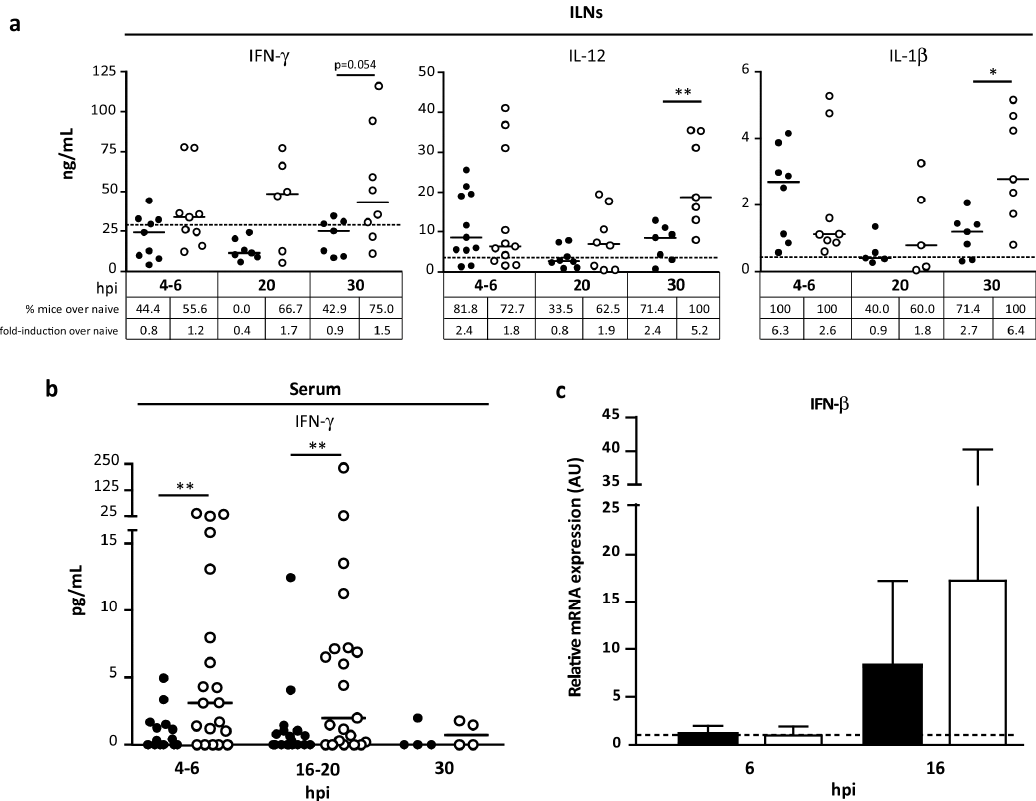
Figure 8. Analysis of the innate immune response in vivo . C57Bl/6 mice were i.m. immunized with 2 × 10 7 PFU of MVAwt (black) or MVA ∆ C12/ ∆ A44L-A46R (white) and at indicated hours post-inoculation (hpi) were sacrificed and samples processed as explained in Materials and Methods. Pro-inflammatory mediators were quantified in homogenates of ILNs ( a ) and serum ( b ) by ELISA. Lines represent median values; dots, individual mice and dotted line, naïve median. ( c ) At six and 16 hpi, six mice per group were sacrificed and RNA was extracted from ILNs. IFN- β mRNA was quantified by qPCR (normalized to β -actin) and relativized to naïve mice group (dotted line). Mann-Whitney test for statistical analysis (* p < 0.05, ** p < 0.01) was performed. Data are representative of two independent experiments.